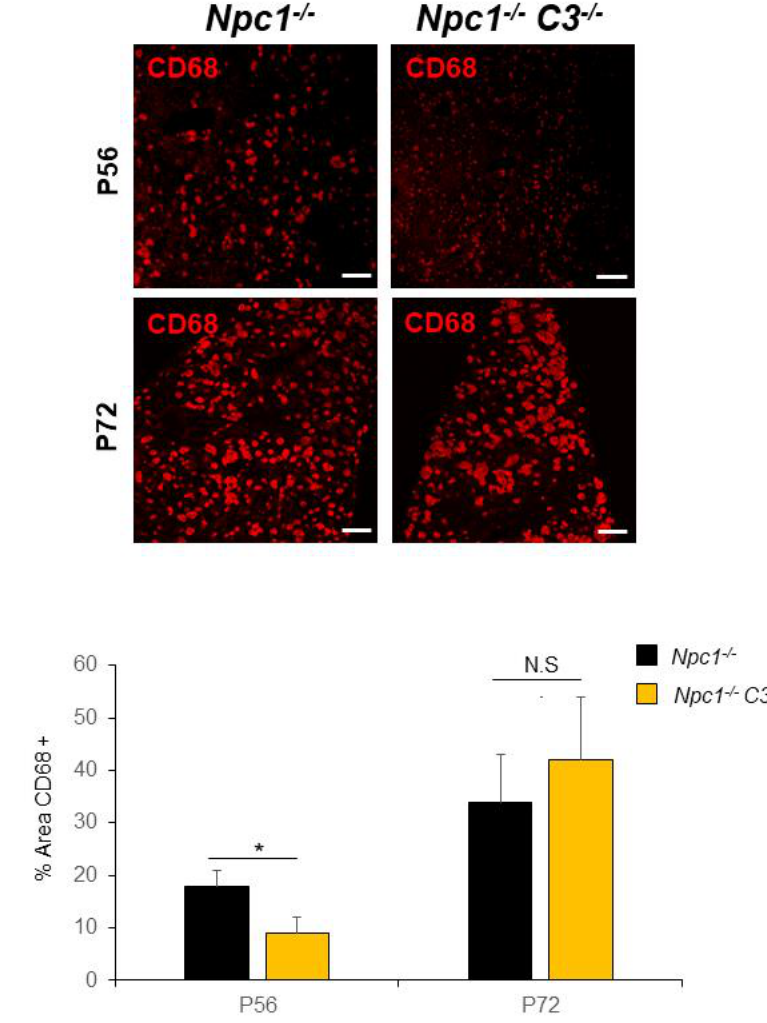
Figure 3. C3 ablation reduced the number of foam cells in NPC livers at P56 but not at P72. ( A ) CD68 (red) was detected in livers of P56 Npc1 − / − and dko C3 − / − Npc1 − / − mice. ( B ) Quantification of the percentage of the area occupied by CD68 cells at the same time points in Npc1 − / − and dko C3 − / − Npc1 − / − mice. Data are presented as means ± SD. ( n = 5 animals / group, two-way ANOVA and Tukey’s multiple comparison post-test). * p < 0.01, compared to the Npc1 − / − group. Scale bars are 50 µ m. Finally, we evaluated other liver damage markers in the same animals such as the levels of − / − alanine and aspartate aminotransferases (ALT and AST) in the serum. The C3 mice showed no significant di ff erence in ALT or AST blood levels compared to wild-type mice ( p = 0.1449 and p = 0.2566, − / − respectively). As expected, Npc1 mice showed increased levels of ALT and AST compared to − / − − / − wild-type mice ( p = 0.0037 and p = 0.0235 respectively) (Figure 4A,B). At P56, dko Npc1 C3 mice − / − showed striking reductions in serum ALT and AST levels compared to Npc1 mice ( p = 0.0161 and p = 0.0378, respectively) (Figure 4A,B). Congruent with previous results showing CD68 levels at P72, − / − − / − − / − no di ff erences were found in the levels of ALT and AST between Npc1 and dko Npc1 C3 mice ( p = 0.9654 and p = 0.0846, respectively). These results demonstrate that C3 ablation prevented NPC liver damage at P56 but not at P72 and suggest that the complement cascade may serve as a new potential therapeutic target for early NPC hepatic